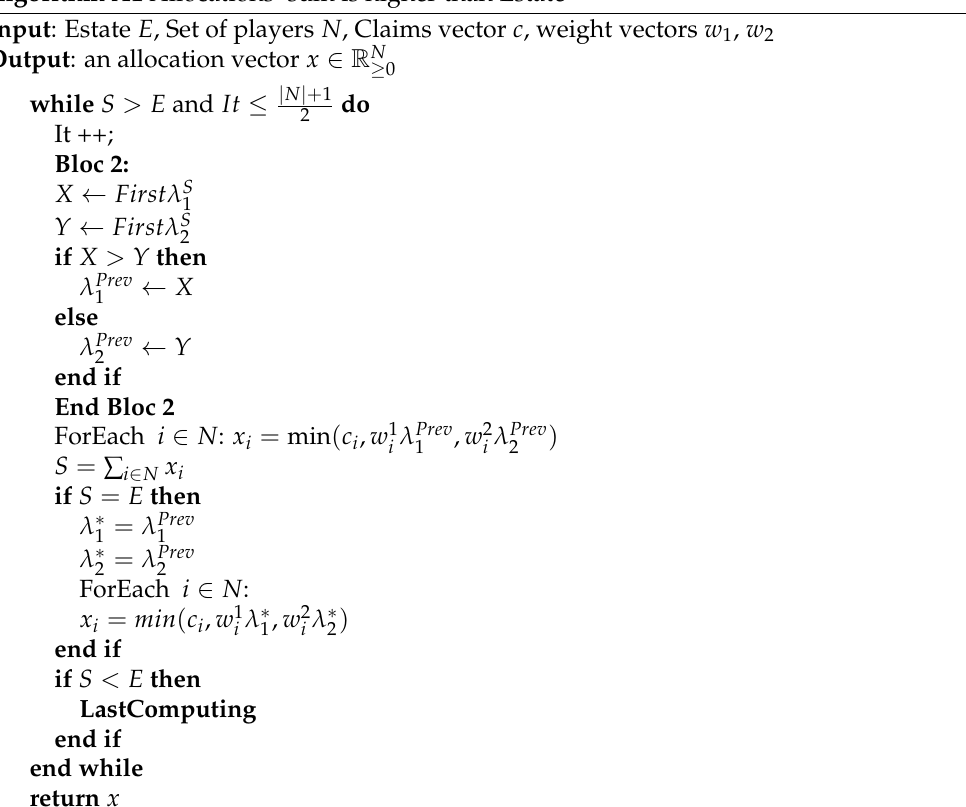
Algorithm A1 Allocations’ sum is higher than